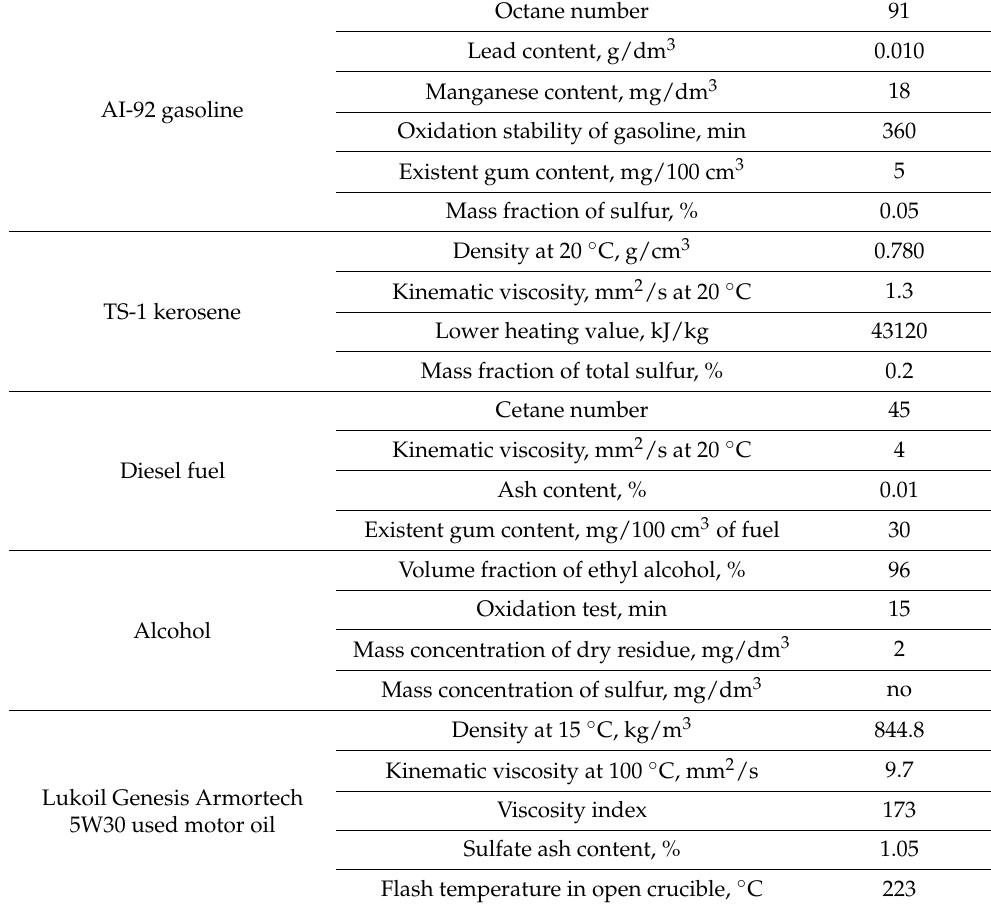
Table 1. Characteristics of flammable liquids and fuels in compliance with regulatory documents [39–42].